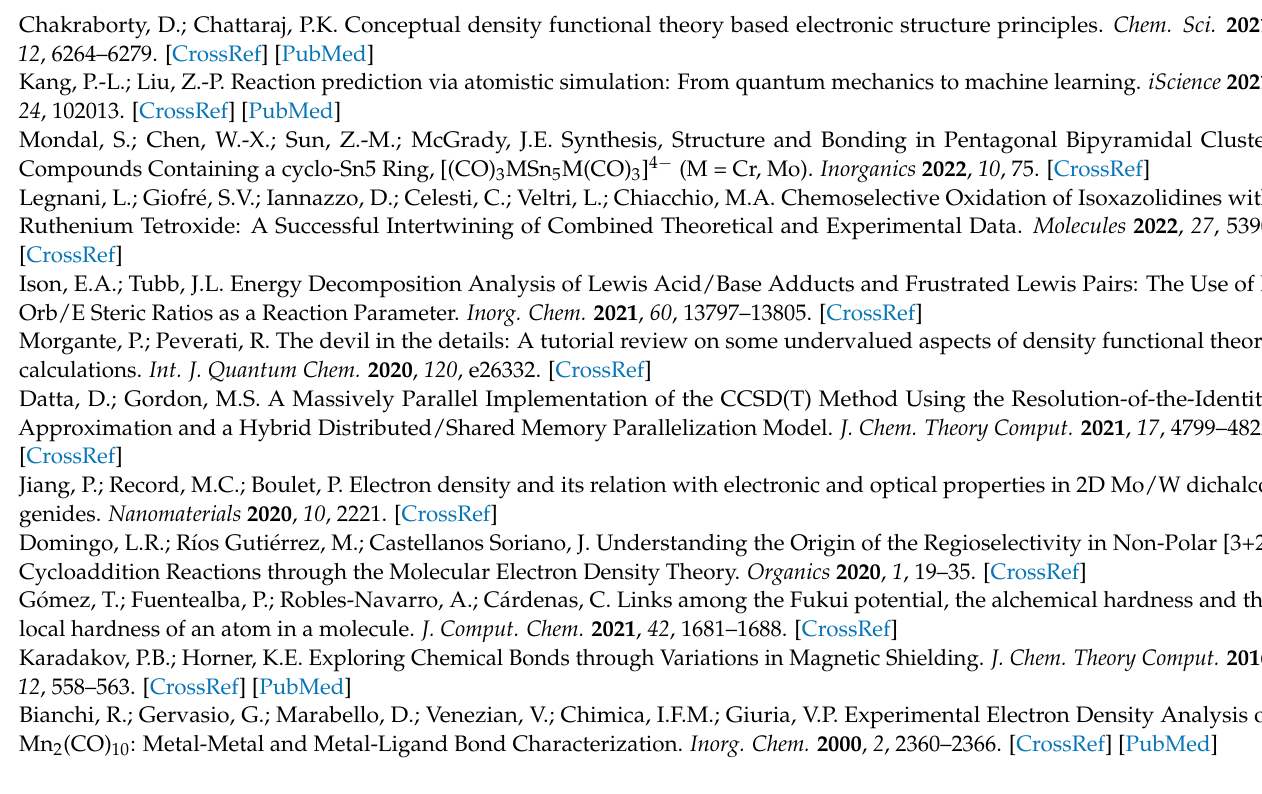
Table S7: Cartesian atomic coordinates of the calculated optimised equilibrium model structures. All coordinates are given in Angstrom